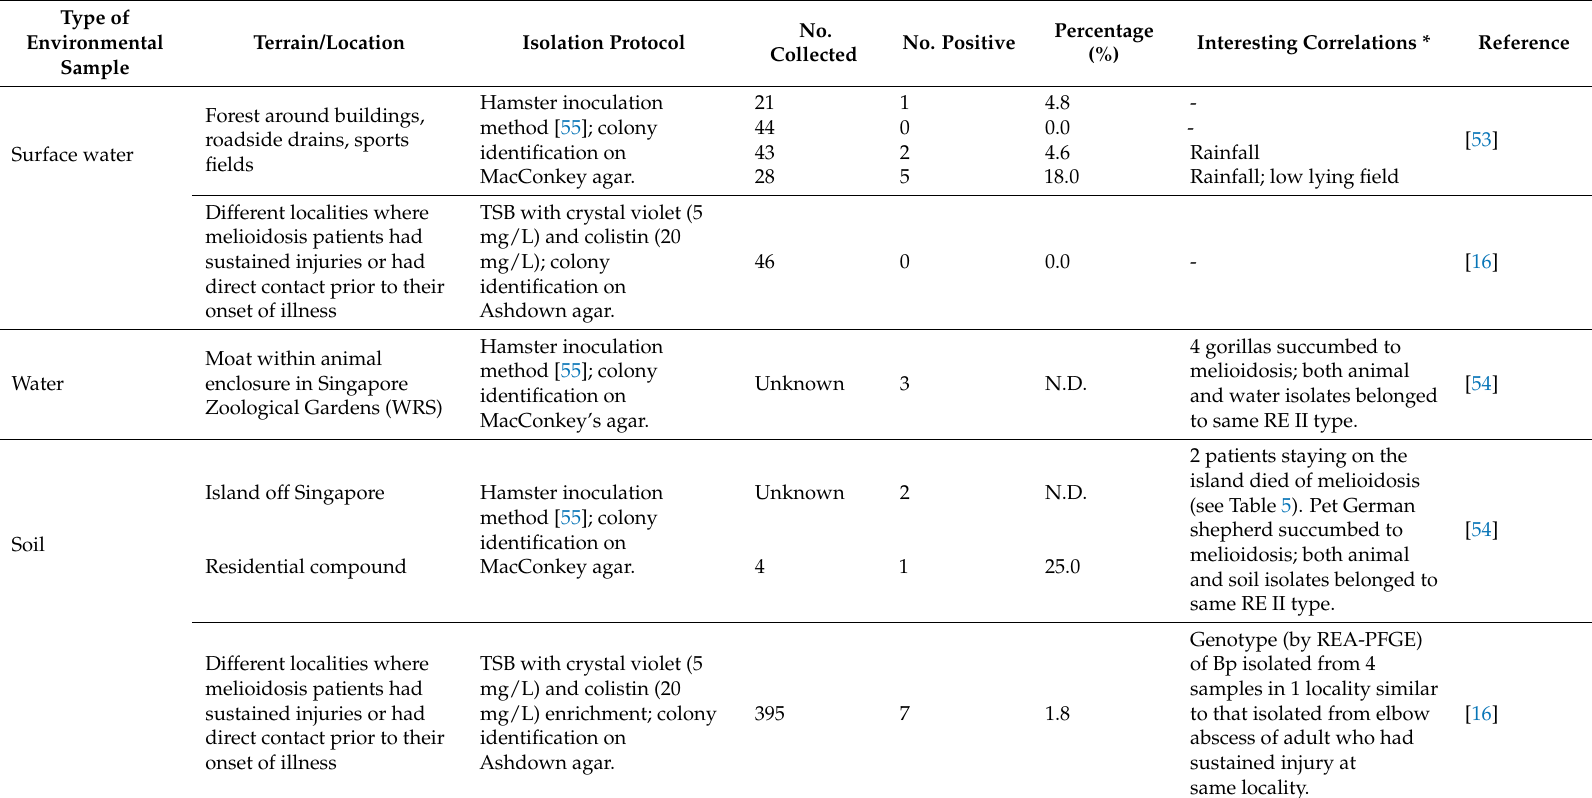
Table 3. Literature review of environmental surveillance for B. pseudomallei in